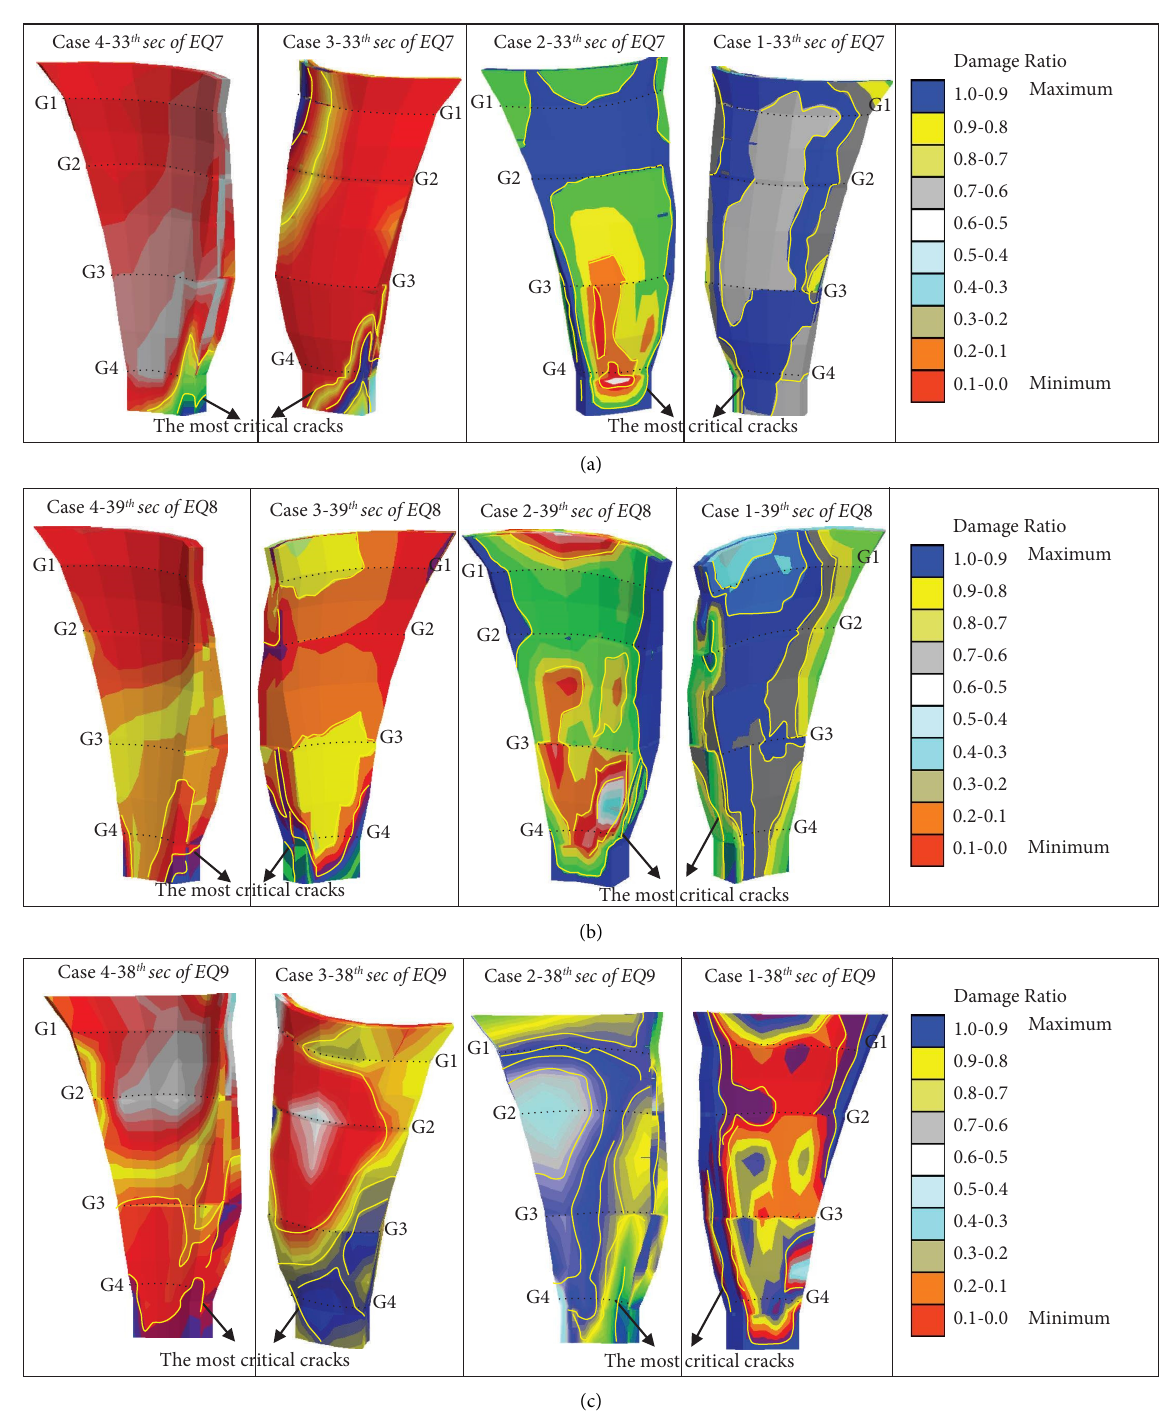
Figure 14: Earthquake crack performance of Ermenek arch dam for (a) EQ7 earthquake, (b) EQ8 earthquake, and (c) EQ9